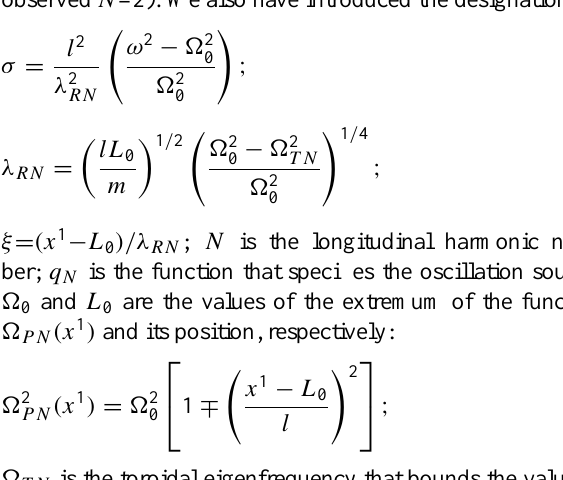
Fig. 2. Structure of the wave across magnetic shells in the Alfv´en waveguide.